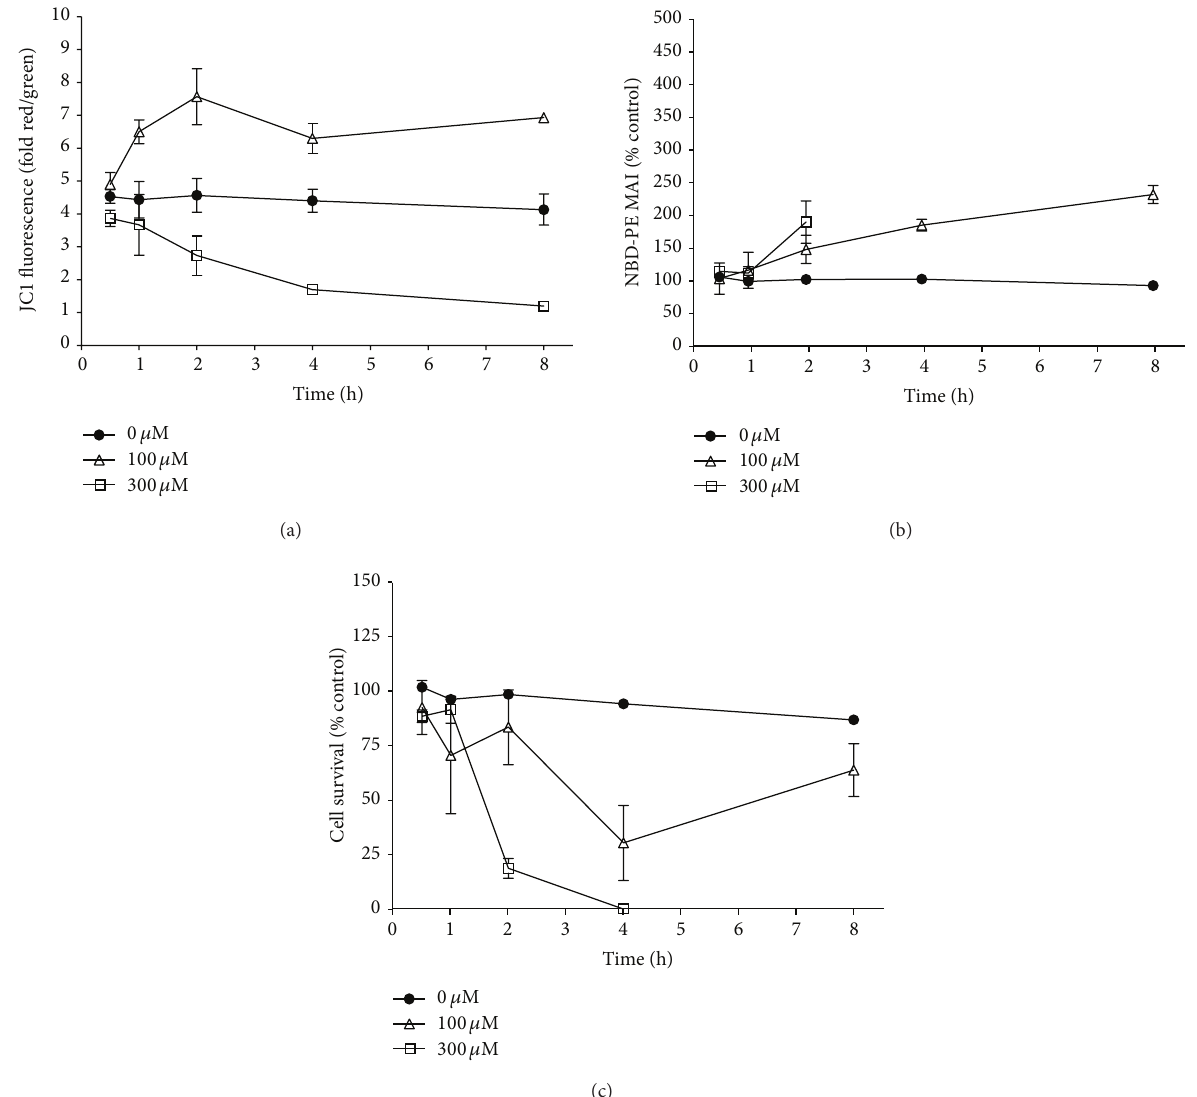
Figure 5: Effect of NMTMB on cell survival, NBD-PE accumulation, and mitochondrial polarization (JC-1 fluorescence) over 8 hours. Rat hepatocytes were treated with NMTMB for 30 minutes, 1h, 2h, 4h, or 8 h. The data are expressed as an average of 3 ( ± SD) replicates from a single cell isolate. A statistically significant difference in JC-1 and NBD-PE levels between corresponding control replicates and that for NMTMB conditions was achieved by 1h and 2h, respectively ( 𝑃 < 0.05 , 𝑡 -test). As there was minimal survival observed for the higher test concentration beyond 2 h, NBDPE levels are not presented beyond